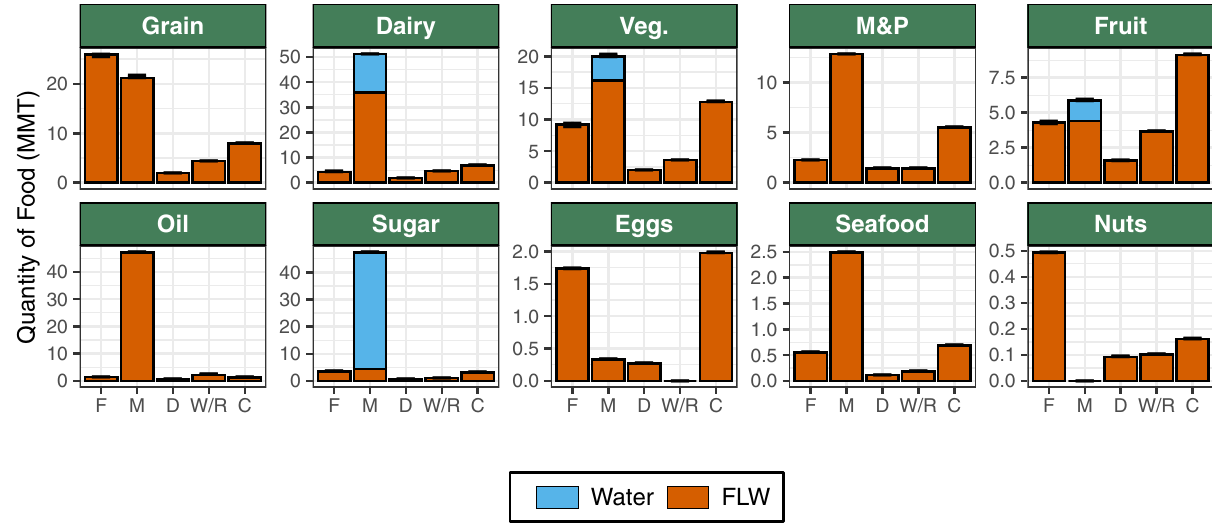
Fig. 6 Con fi dence interval and FLW by FSC stages and food commodities. Detailing the 95% con fi dence interval (black error bars) for total FLW (as either water evaporated during food manufacturing process [Water, blue] or FLW [vermillion]) for each commodity in the different stages. The 10 commodities are represented with their own labeled panel (M&P represents meat and poultry) and each stage is a different column (on-farm production [F], food manufacturing [M], distribution [D], wholesale & retail [W/R], consumption [C]). The y -axes labels vary between panels so mass fl ow details are more visible.